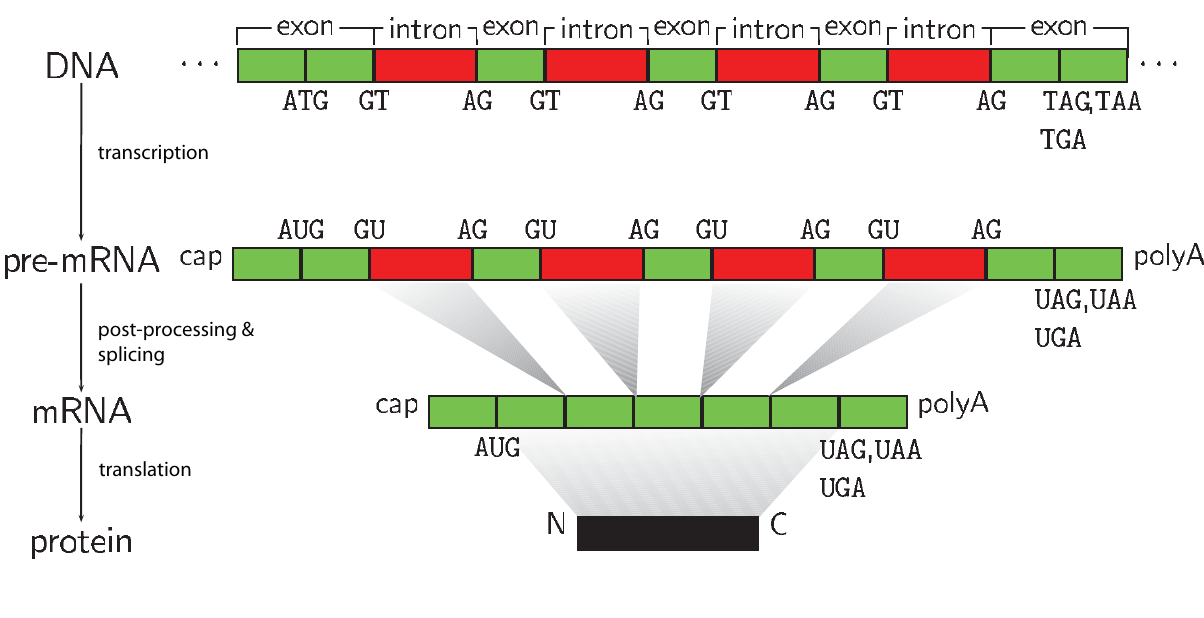
Figure 4. The major steps in protein synthesis: transcription, post-processing, and translation. In the post-processing step, the pre- mRNA is transformed into mRNA. One necessary step in the process of obtaining mature mRNA is called splicing . The mRNA sequence of a eukaryotic gene is ‘‘interrupted’’ by noncoding regions called introns . A gene starts with an exon and may then be interrupted by an intron, followed by another exon, intron, and so on until it ends in an exon. In the splicing process, the introns are removed. There are two different splice sites: the exon–intron boundary, referred to as the donor site or 5 9 site (of the intron), and the intron–exon boundary, that is, the acceptor or 3 9 site. Splice sites have quite strong consensus sequences, i.e., almost every position in a small window around the splice site is representative of the most frequently occurring nucleotide when many existing sequences are compared in an alignment (cf. Figure 5). (The caption text appeared similarly in [30], the idea for this figure is from